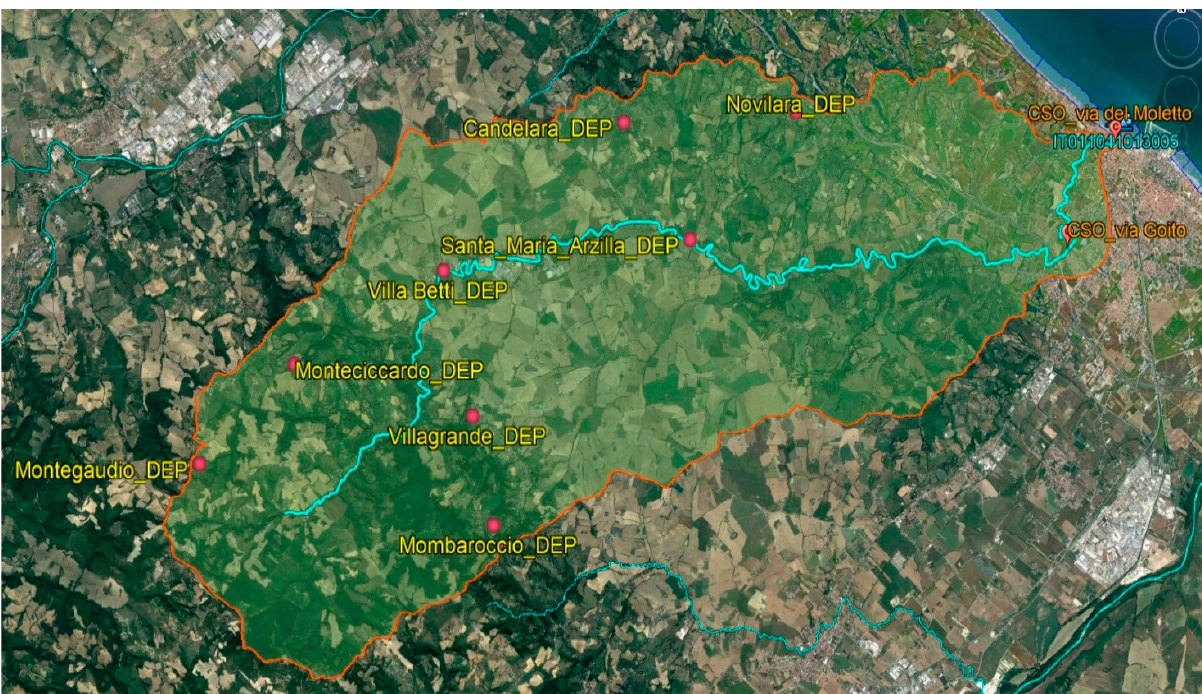
Figure 1. The hydrographic basin of the Azilla River (light blue line). An area of 105 square kilometres, delimited by the orange line. In the map, the purification systems (marked with DEP and shown as red dots) releasing wastewaters into the Arzilla River, two CSOs of the urban network of the Fano city (CSO_via del Moletto and CSO_via Goito, shown as red placemarks), and bathing areas (light blue lines) along the coast near the mouth of the Arzilla stream: IT01104013005 is shown.